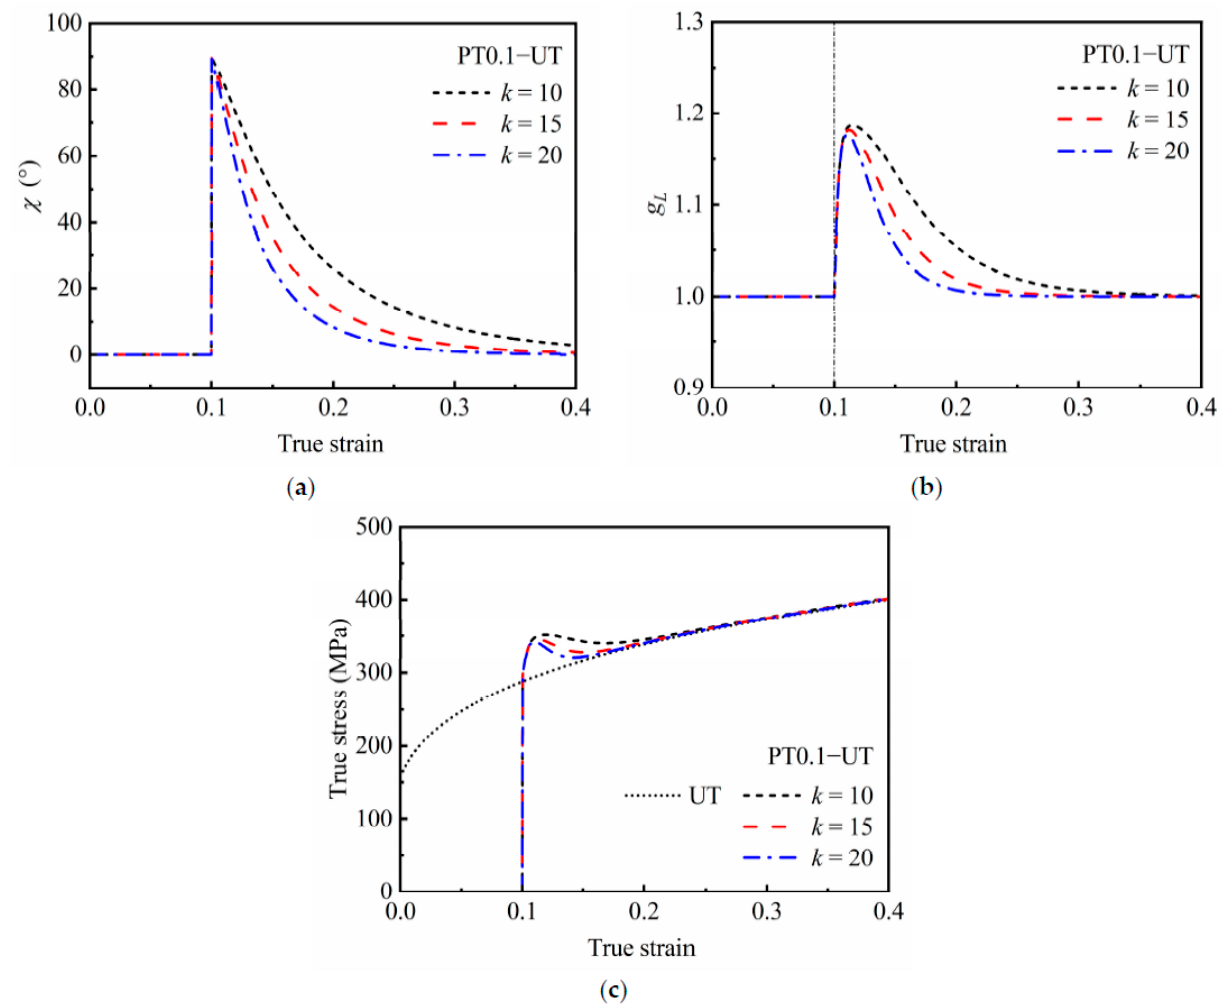
Figure 10. Predicted responses of latent hardening effect during cross loading of PT0.1 − UT under different k : ( a ) evaluation of χ , ( b ) evaluation of g L and ( c ) stress–strain